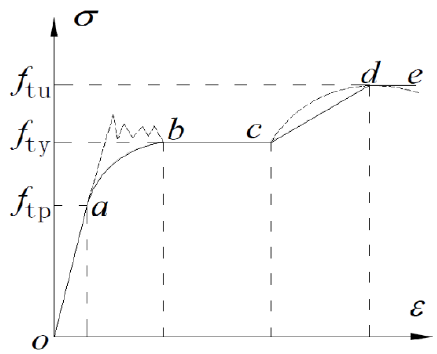
Figure 2. Stress-strain curve of steel.